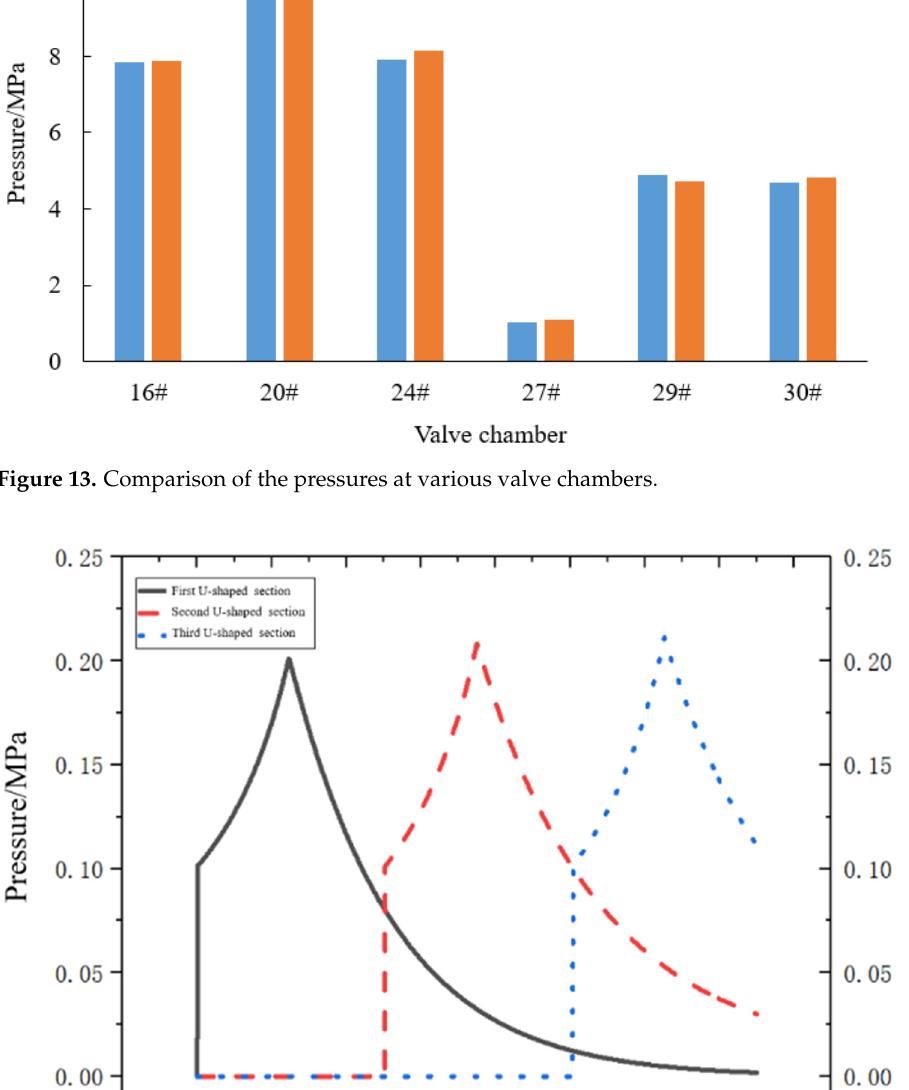
Figure 12. Comparison of the inlet pressure at pump station #2.